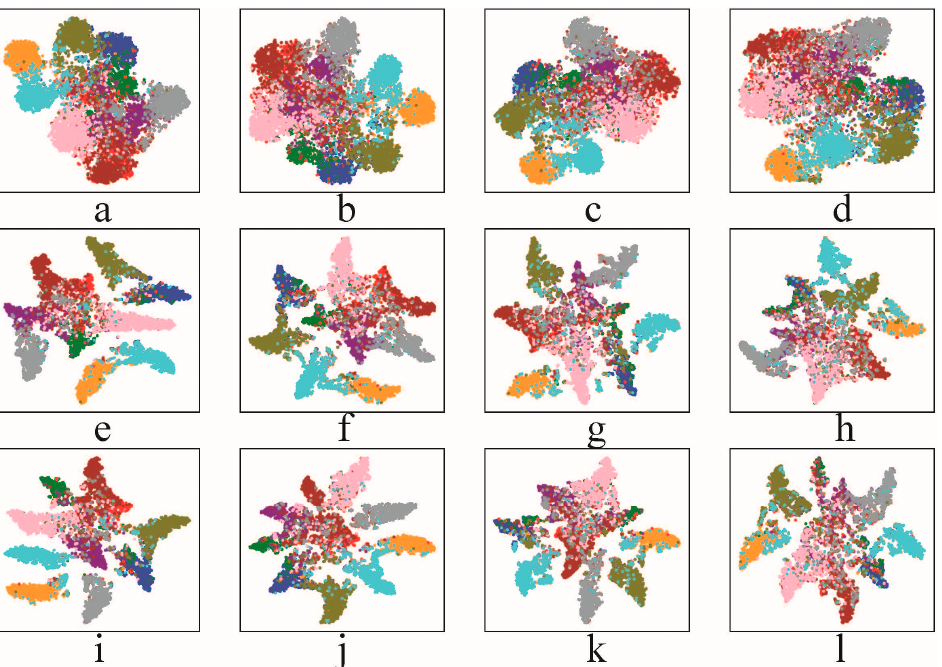
Figure 7. t-SNE visualization of the feature distribution of adversarial examples of ResNet34 networks trained using ( a – d ) standard AT, ( e – h ) BCAT, and ( i – l ) BCAT+ on CIFAR-10.